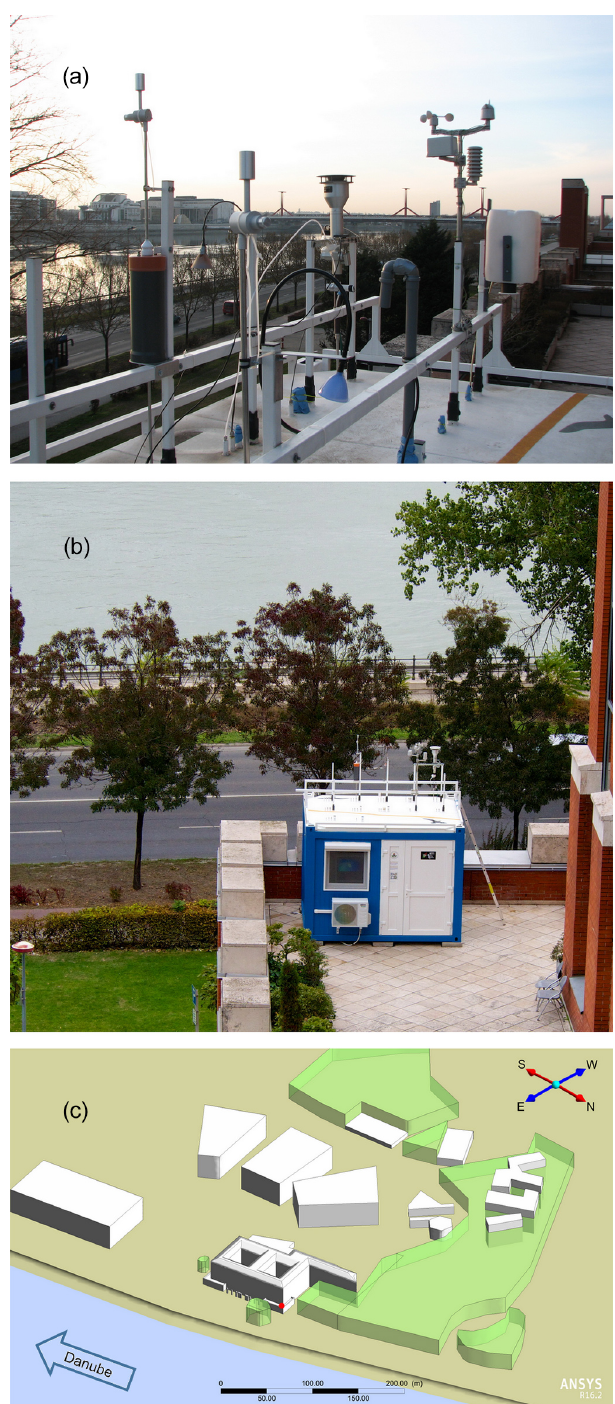
Figure 1. The superstructure (a) and close surroundings (b) of the BpART facility, together with a geometrical representation of the buildings and vegetation in a perspective view (c) utilised in the CFD modelling. The location of the platform is indicated by a red dot, and a compass rose is also shown in the lowest